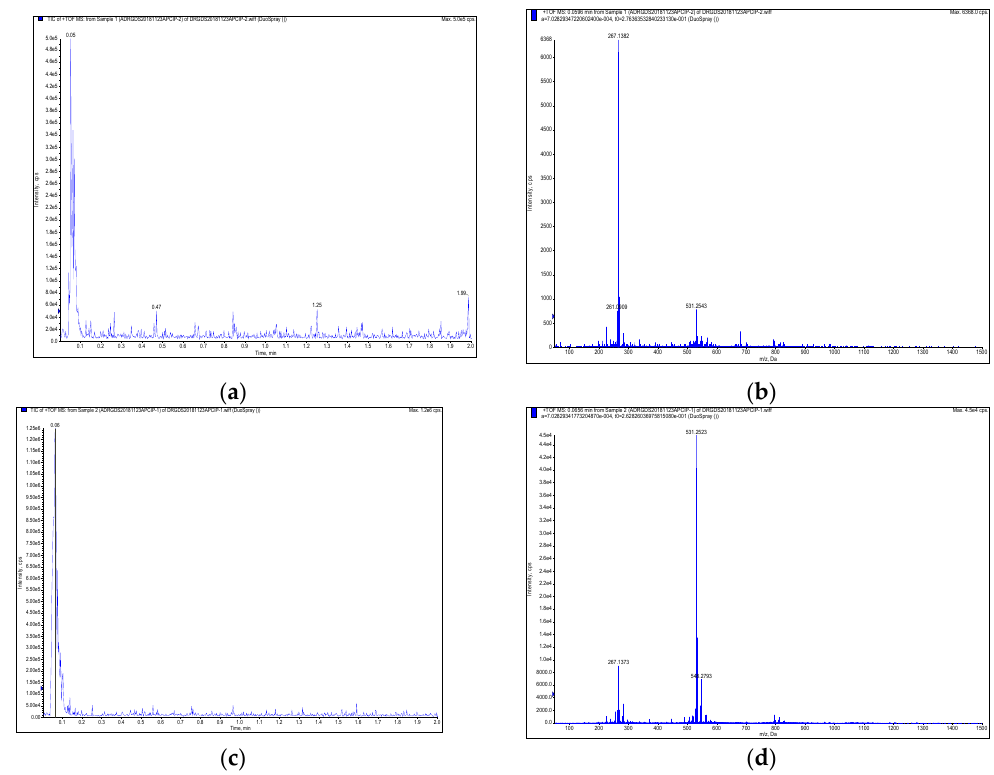
Figure 3. The identification of magnolol and honokiol by high-performance liquid chromatography/mass spectrometry (HPLC/MS) chromatogram. ( a , b ) Magnolol; ( c , d ) honokiol.